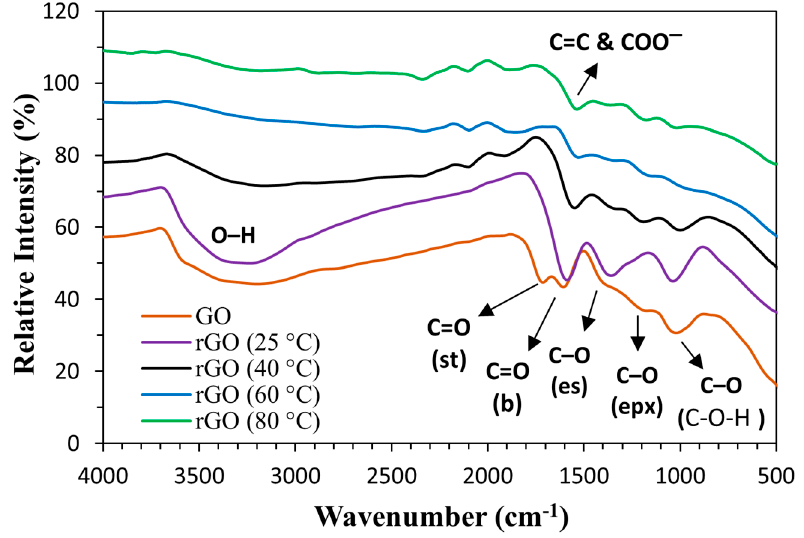
Figure 4. FTIR spectra of GO and rGO synthesized using lemon juice at different temperatures (conditions: pH = 12.3 and 2 h).